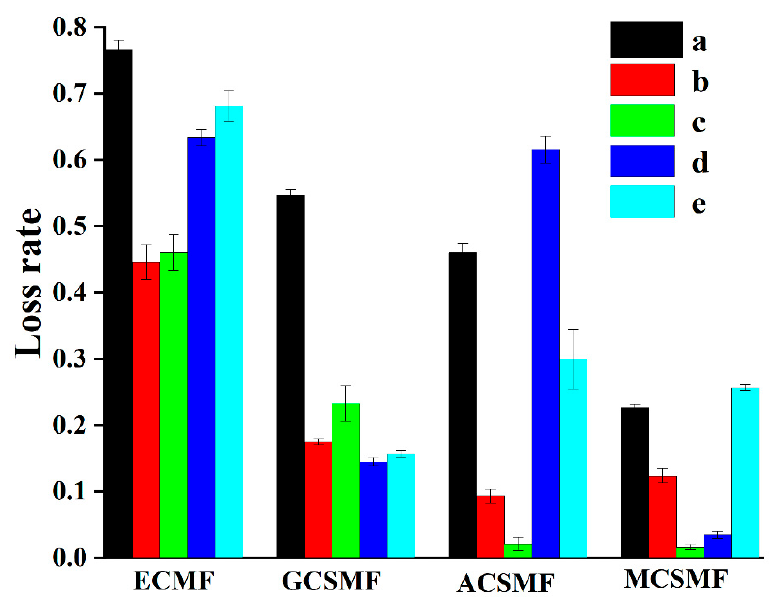
Figure 8. GCMS analysis of characteristic aroma components of scented cotton fabric after heat treatment with ECMF, GCSMF, ACSMF, and MCSMF: (a) β -caryophyllene; (b) limonene; (c) thymol; (d)